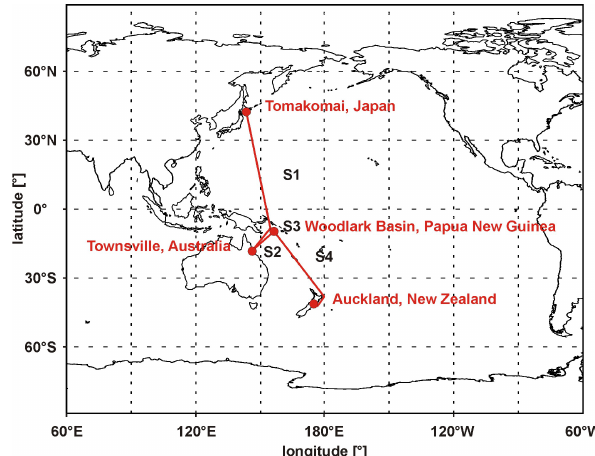
Fig. 1. Overview of the ship campaign with RV Sonne in the West- ern Pacific between 9 October 2009 and 5 December 2009 from Tomakomai, Japan, to Auckland, New Zealand, divided into four sections (S1–S4) according to Table 1. The red line indicates the approximate ship track. Section S1 is further described in Kr¨uger and Quack